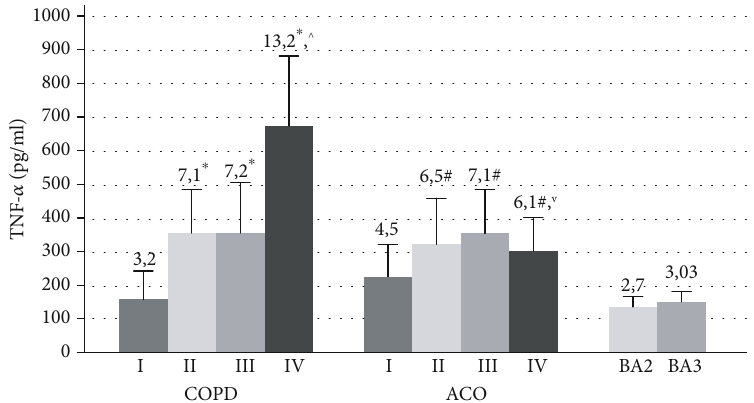
Figure 7: The serum concentration of TNF- α in patients with COPD, ACO, and BA with varying severity of disease and airway obstruction. COPD: chronic obstructive pulmonary disease; ACO: asthma-COPD overlap; BA: bronchial asthma; I: GOLDI, ACOI; II: GOLDII, ACOII; III: GOLDIII, ACOIII; IV: GOLDIV, ACOIV; BA2: moderate bronchial asthma, BA3: severe bronchial asthma; ∗ p < 0 : 05 versus patients with GOLDI, ^ p < 0 : 05 versus patients with GOLDII and GOLDIII; ∨ p < 0 : 05 versus patients with ACOIV; # p < 0 : 05 versus patients with ACOI. Table 2: Correlations between the serum levels of IL-17, IL-18, and TNF- α in all examined patients with COPD, asthma-COPD overlap, and bronchial asthma. BA All examined patients